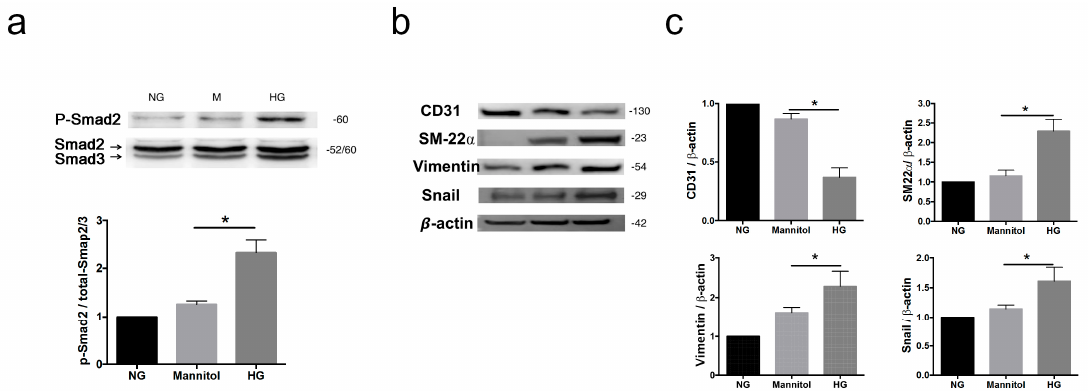
Figure 4. High glucose promotes EndMT in HUVECs. ( a ) Representative images of the western blot analysis of p-Smad2 protein levels. Total Smad2 / 3 served as the loading control. The quantification of protein levels is presented as mean ± SD from three independent experiments. ( b ) Representative images of the western blot analysis of CD31, SM22 α , vimentin, and Snail protein levels in HUVECs treated with di ff erent conditions. ( c ) Quantification of the relative fold increase is shown as the mean ± SD from three independent experiments. * P < 0.05. The statistical significance was assessed by Kruskal–Wallis test.